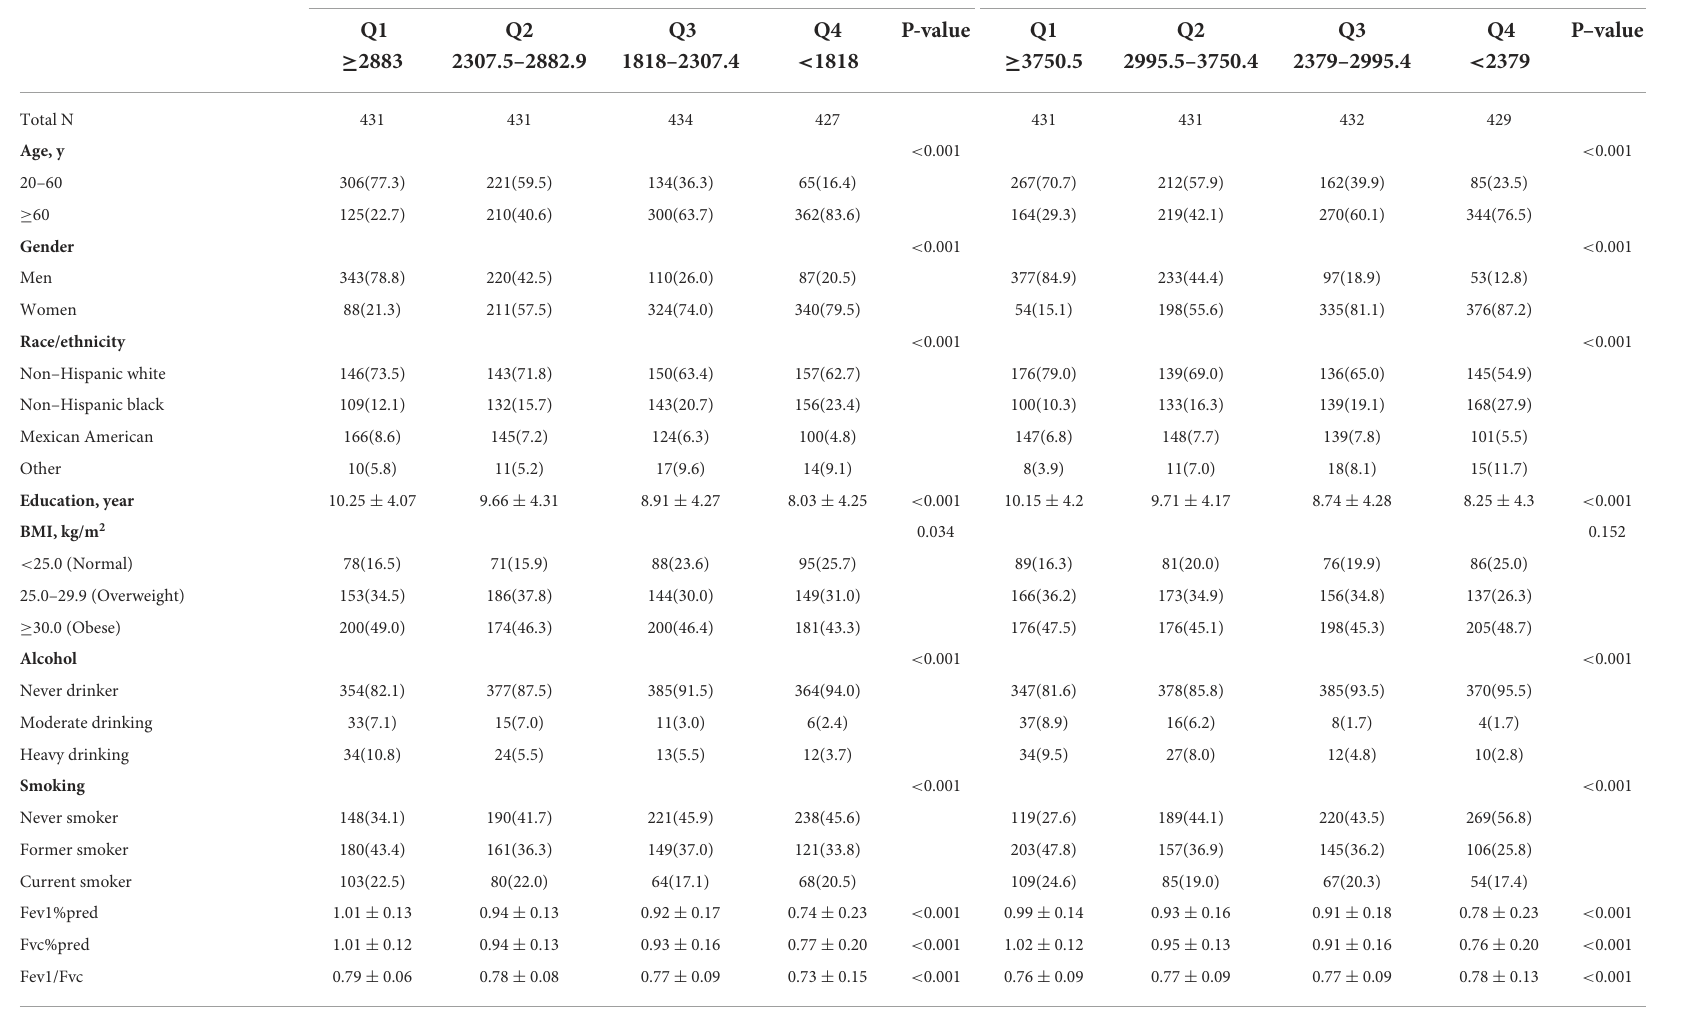
TABLE 1 Baseline demographic characteristics of the study population, according to quartiles of FEV1, FVC.